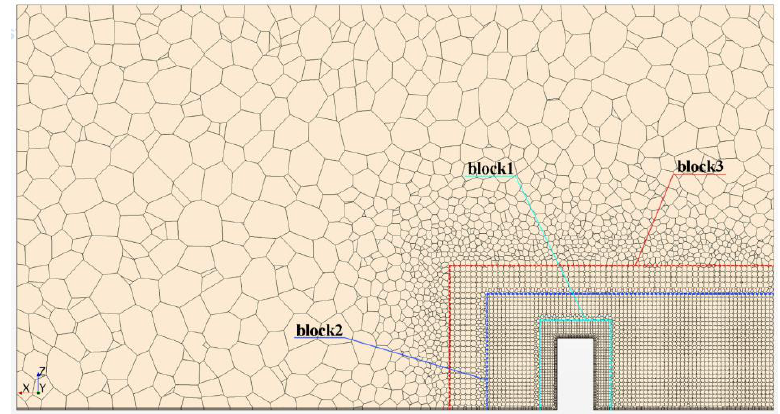
Figure 7. Section of mesh scheme for Case 2.